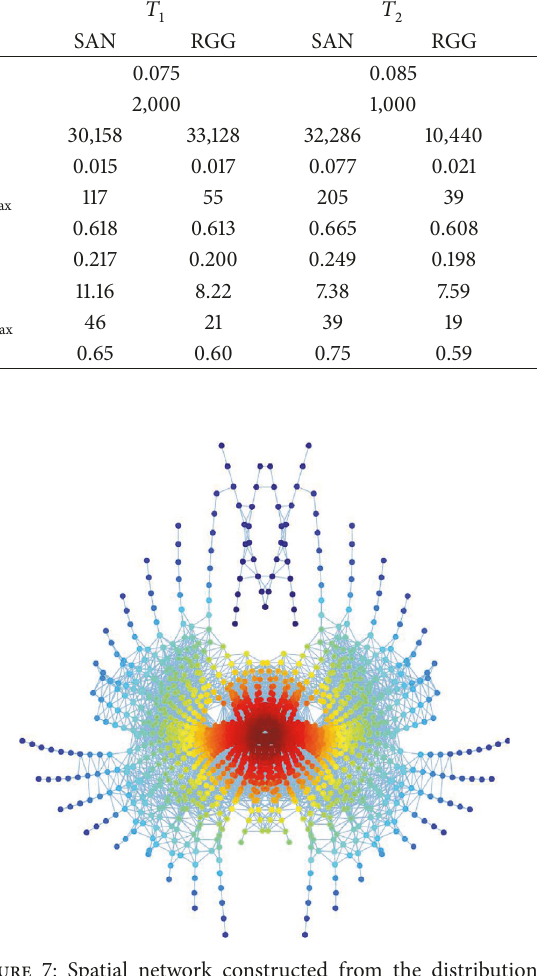
Figure 7: Spatial network constructed from the distribution of pointsinaunitsquareaccordingtothetransform 𝑇 4 usingaconnec- tion radius 𝑅 = 0.085 with 𝑛 = 2000 points and coloring the nodes according to their closeness centrality.